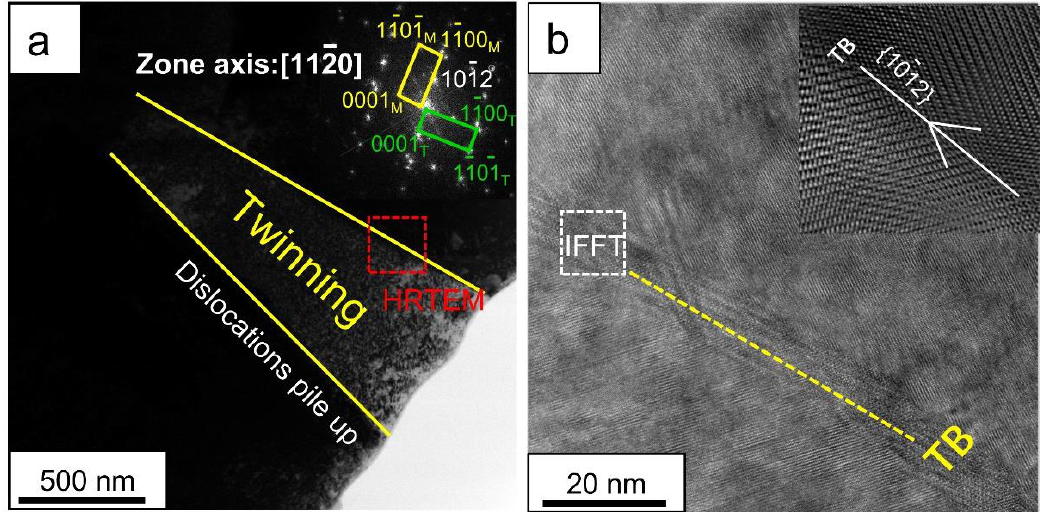
Figure 7. TEM images showing tensile deformation micro-mechanisms for the heat treatment alloy. ( a ) BF image and corresponding SAED pattern; ( b ) corresponding high-resolution TEM micrograph (HRTEM) pattern showing a { 101̅2 } < 101̅1 > twin.